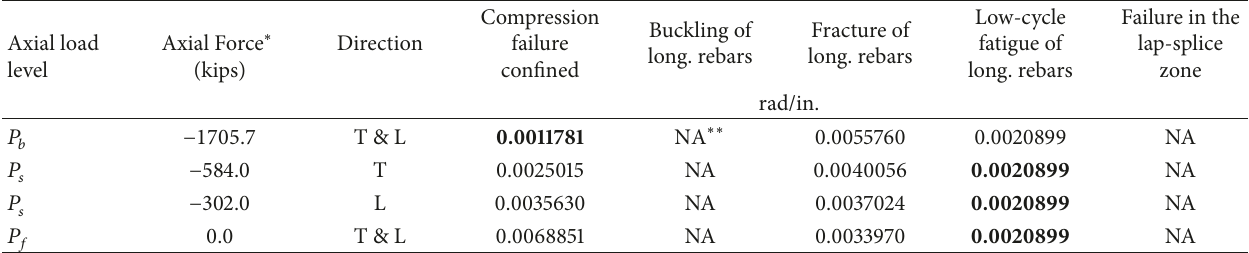
Table 8: Plastic curvature capacity of Pier #2 widened columns, Bridge #1-W.